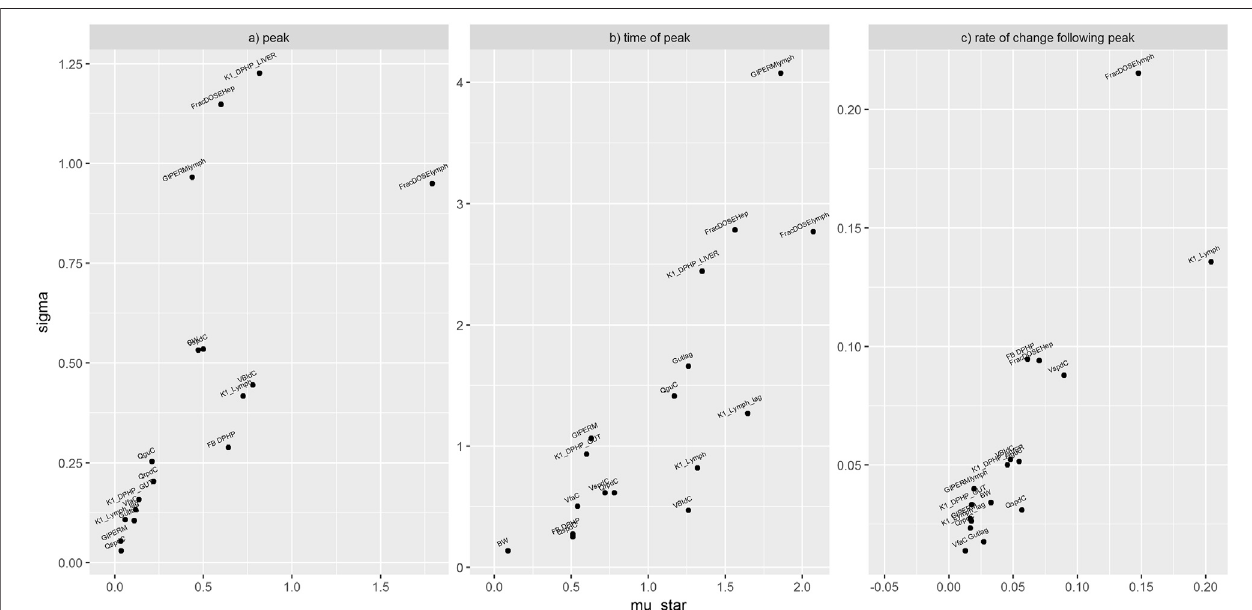
FIGURE5| Elementaryeffectsscreening(MorrisTest)ofthemassofDPHPinplasma.SensitivityofthepeakmassofDPHPinplasma(mg) (A) ,thetimewhenpeak concentration was reached (hours after dosing) (B) and the rate of change of DPHP in plasma (mg/hour) in the hour following peak concentration (C) . Areas with overlapping parameter labels represent clusters of parameters with minimal